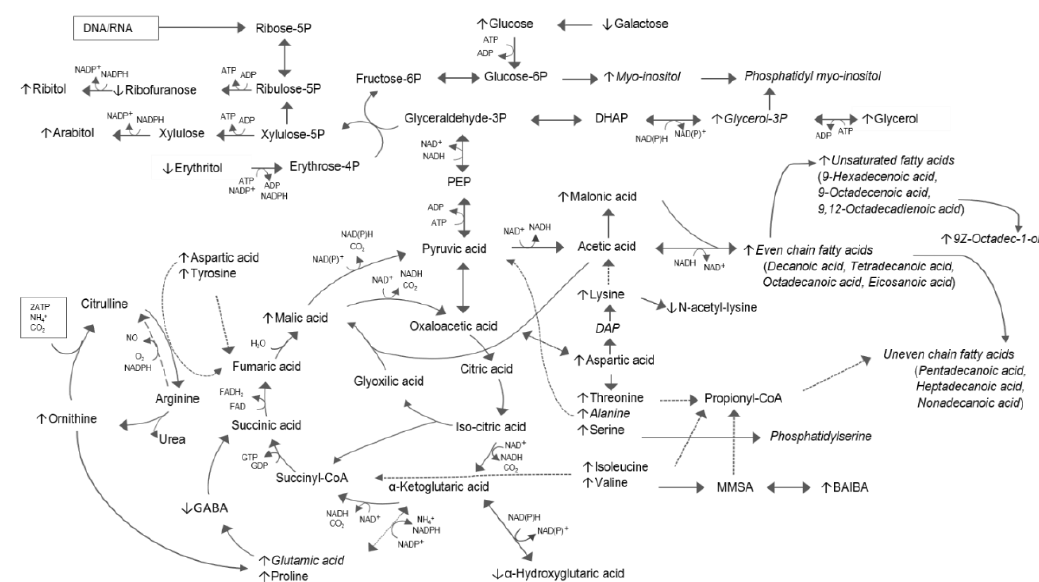
Figure 3. Metabolomic pathway map of DQ derivative RMB041-treated Mtb . The metabolite markers best describing the variation in the metabolome compared to that of untreated Mtb are represented with up or down arrows, indicating elevated or reduced concentrations, respectively. The dotted lines represent flux of amino acids from nucleotide degradation into the central carbon metabolism. Metabolites that are incorporated into the cell wall are indicated in